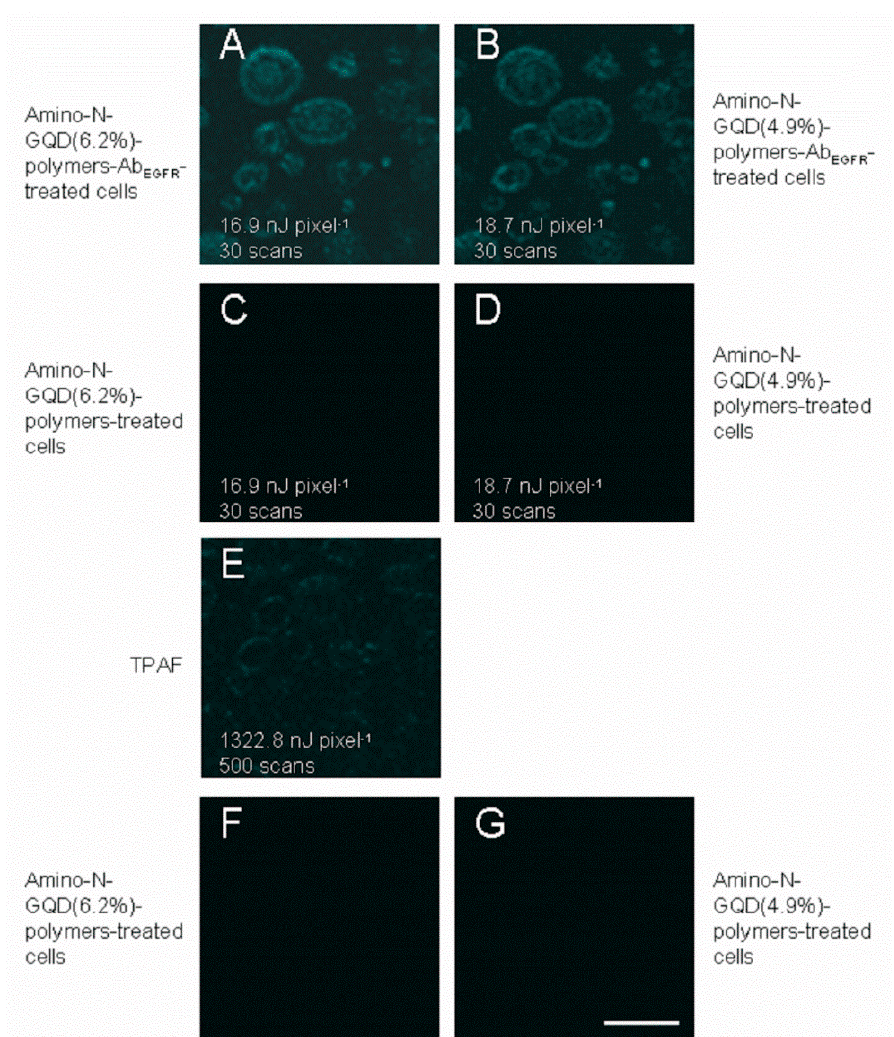
Figure 5. TPL images (cyan) derived at an imaging depth of 105 µm. ( A ) Amino-N-GQD (6.2%)-and ( B ) amino-N-GQD (4.9%)-Ab EGFR -treated cells observed at TPE power levels of 16.9 and 18.7 nJ pixel − 1 over 30 scans, respectively. ( C , D ) Amino-N-GQD-polymer-treated cells not coated with an antibody underwent the same treatment. ( E ) TPAF images of the unlabeled cells (cells with no treatment materials) were captured at a TPE power of 1322.8 nJ pixel − 1 over 500 scans. ( F , G ) Images of the amino-N-GQD-polymer-Ab EGFR -treated cells at the same depth with an OPE power of 9 mW. The delivered dose of the material was 4 µg mL − 1 in cell culture medium; the excitation wavelength was 800 nm; and the scale bar is 20 µm.